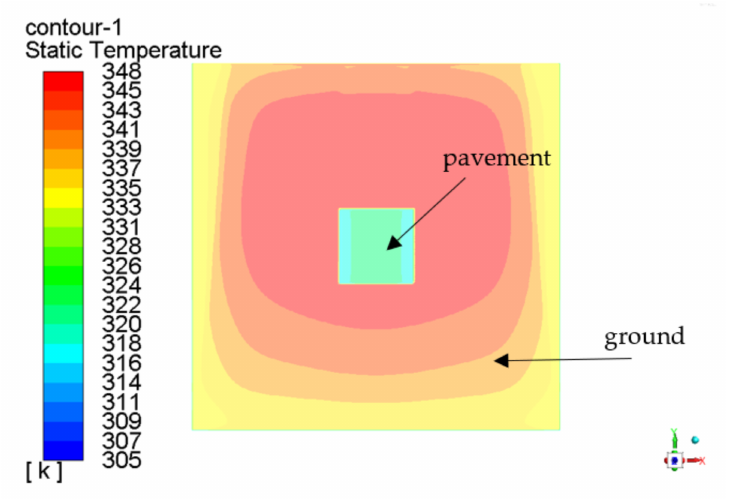
Figure 7. Temperature profile with asphalt albedo value of